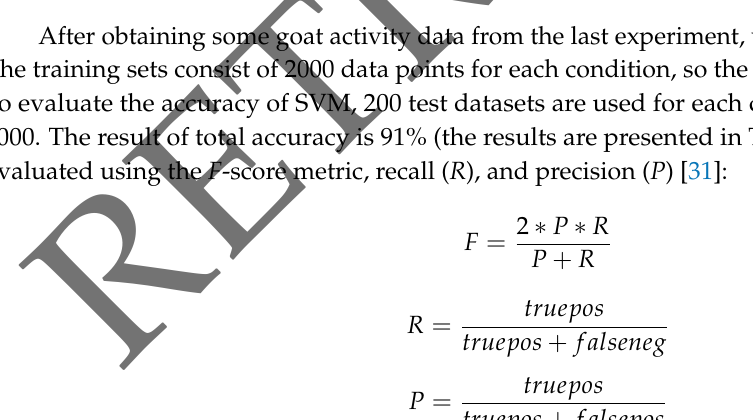
Figure 9. RBF kernel SVM gamma and C parameters selection process. ( a ) Visualization of the decision function for a variety of parameter values. ( b ) A heatmap of the classifier’s cross-validation accuracy as a function of C and gamma .